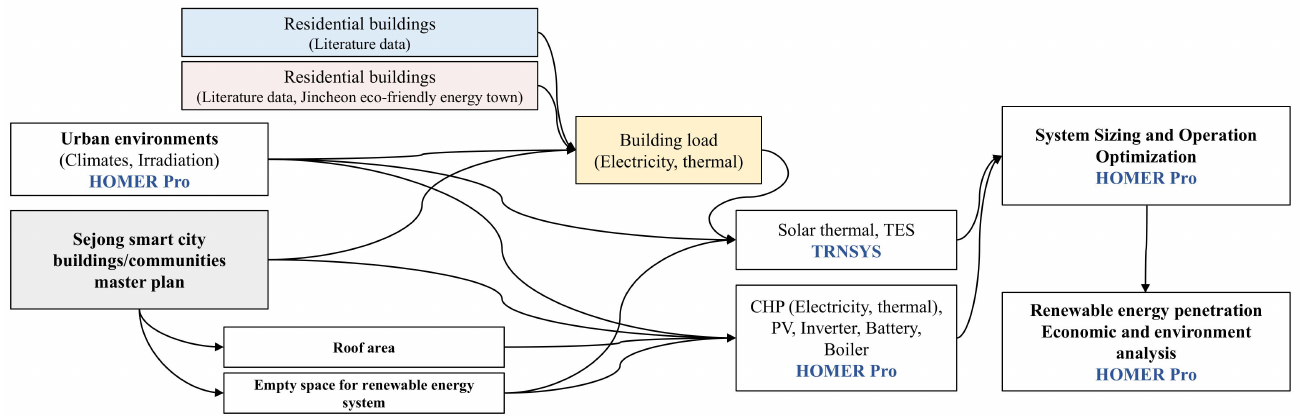
Figure 1. Overview of simulation